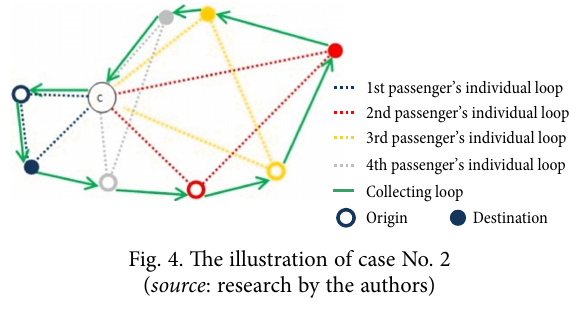
Table 5. Mixed prices paid by passengers in case No. 1 Pass. No.